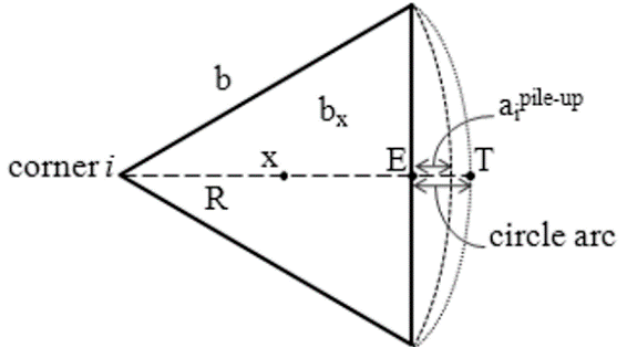
Figure 7. Schematic of the pile ‐ up model. R is the arc radius (used in the method ‐ 2 model of pile ‐ up); point T is the farthermost point from corner i of pile ‐ up used for the evaluation of the circle arc (method ‐ 2); x is the height of the triangular projected area meeting the triangular edge at point E; a ipile up is the horizontal projection of the tallest ridge (used in method ‐ 1 of pile ‐ up). a ipile up is the horizontal projection of the tallest ridge (used in method-1 of The three terms ai are directly measured taking the produced indent profile image.